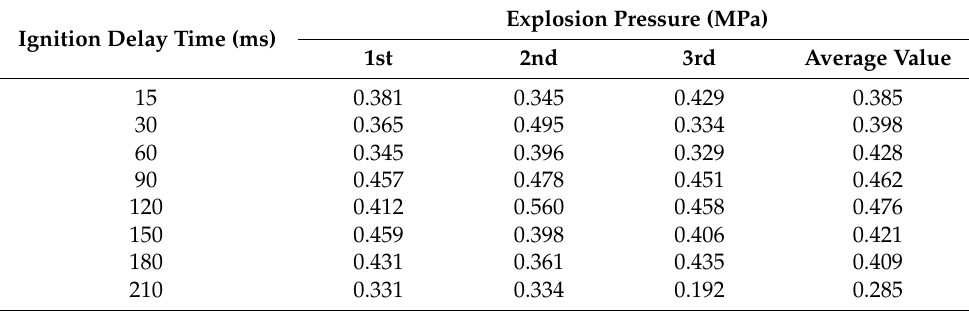
Table 1. Explosion pressure of cassava starch dust under different ignition delay times.